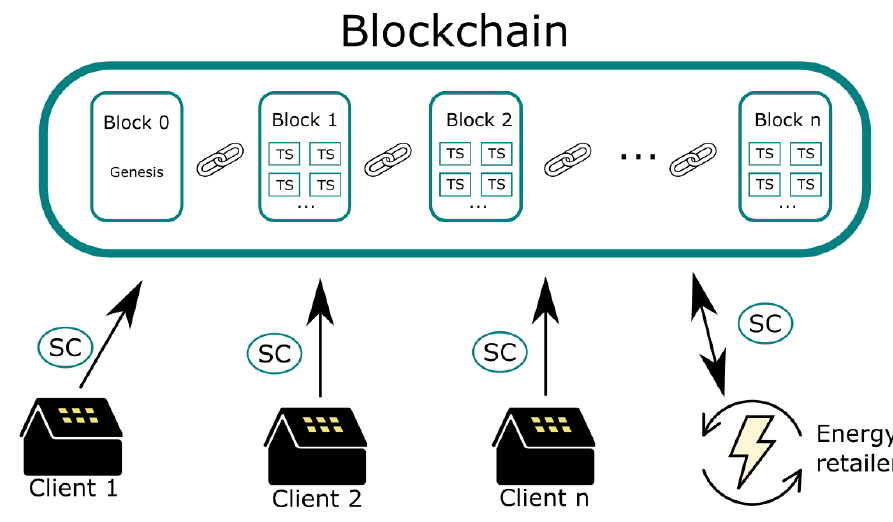
Figure 2. Marketplace